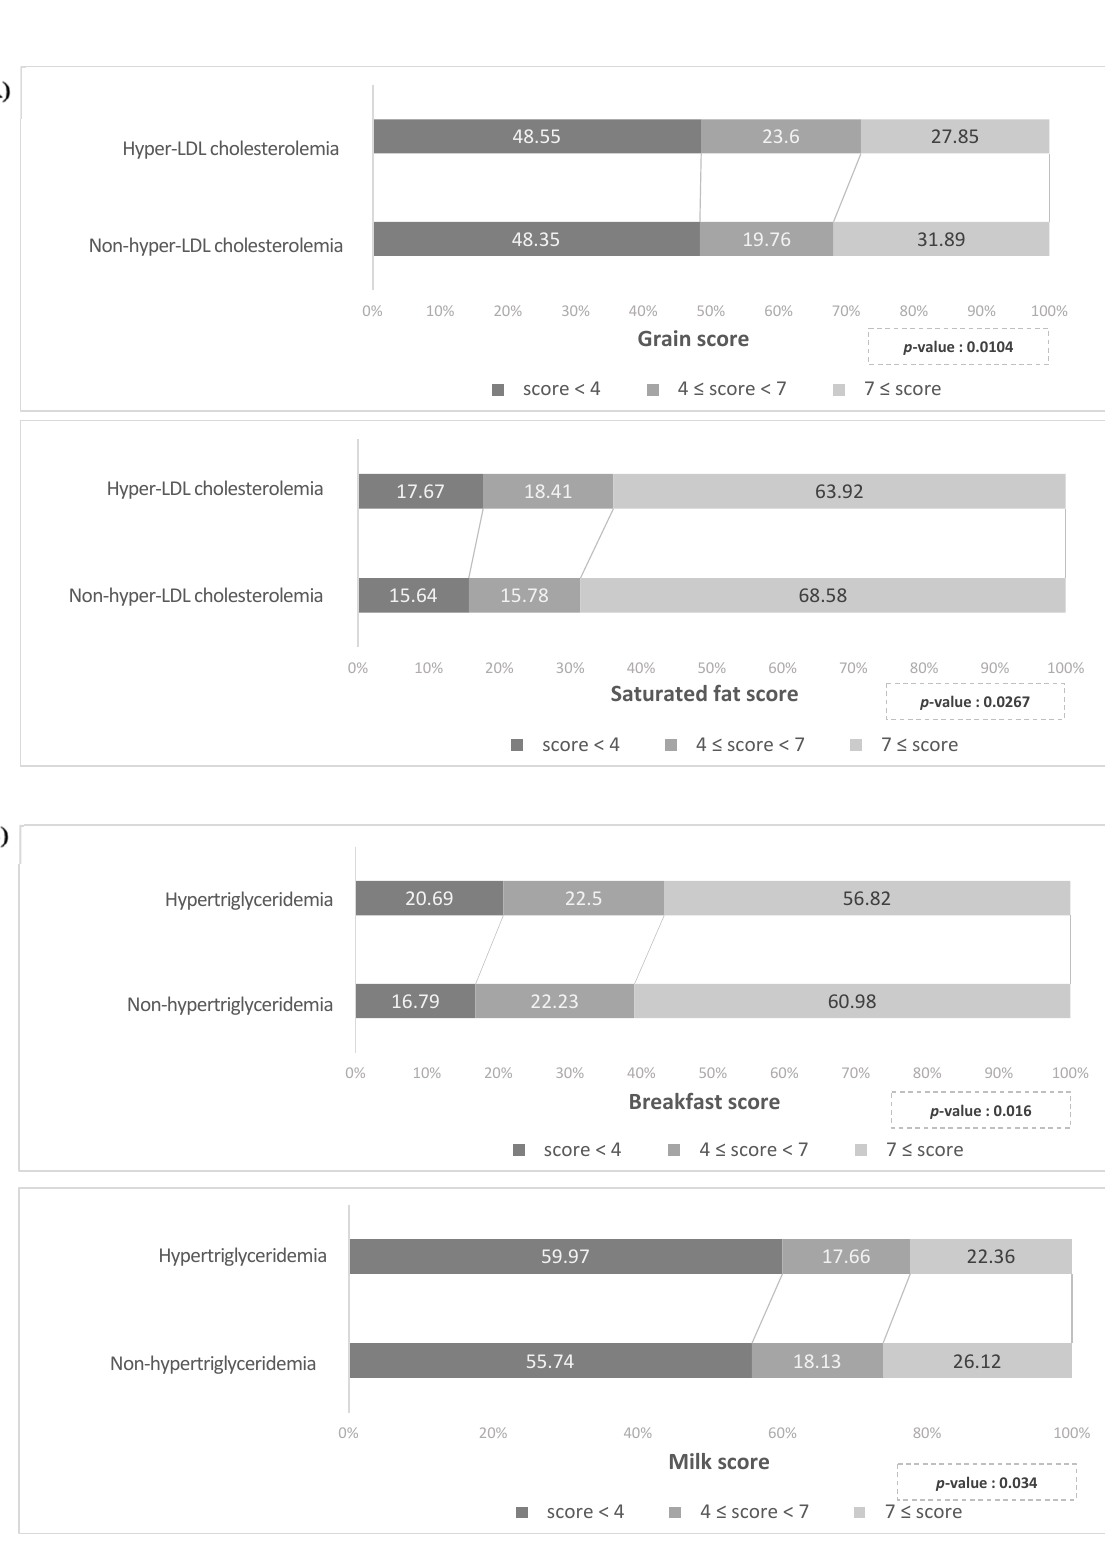
Figure 2. Percentages of participants in different categories for various Korean Healthy Eating Index components. Each Korean Healthy Eating Index component was categorized into three groups: low score: 0 ≤ score < 4, middle score: 4 ≤ score < 7, and high score: ≥ 7 points. p -values were calculated using the chi-squared test. ( A ) Percentages for each category of “whole grains” and “saturated fatty acids” scores in participants with or without hyper-LDL cholesterolemia. ( B ) Percentages for each category of “having breakfast” and “milk and dairy products” scores in participants with or without